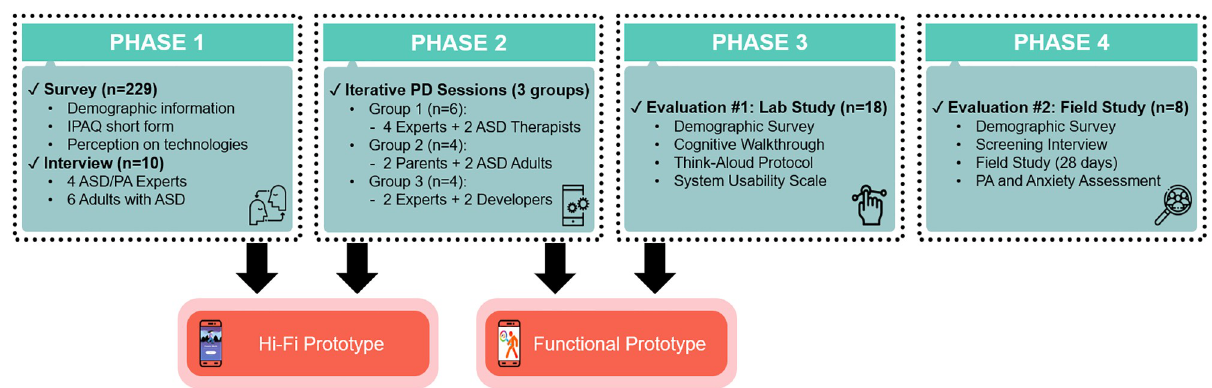
Fig 1. Overall research procedure across four phases of the study. In Phase 2, “PD” = participatory design, “Parents” = parents of a child with ASD, and “Experts” = ASD/PA experts. We held three iterative PD sessions with each group, totaling nine PD sessions.